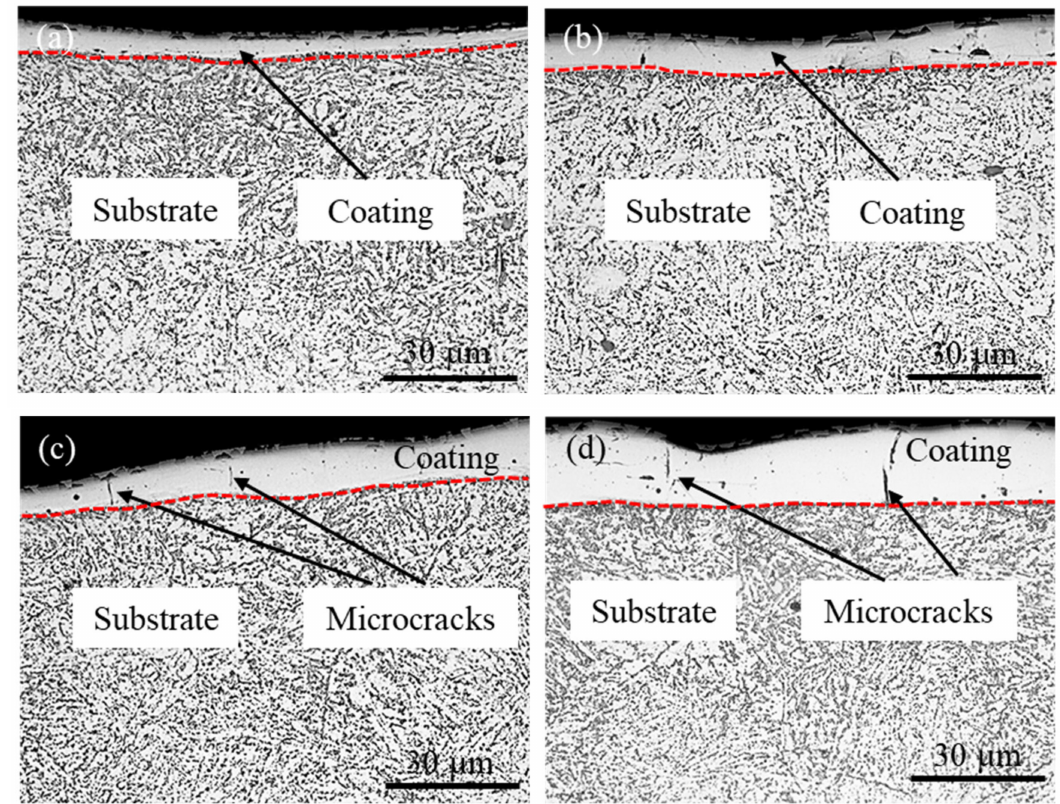
Figure 8. Cross-sectional images of coating: ( a ) 2 min/cm 2 , ( b ) 3 min/cm 2 , ( c ) 4 min/cm 2 , and ( d ) 5 min/cm 2